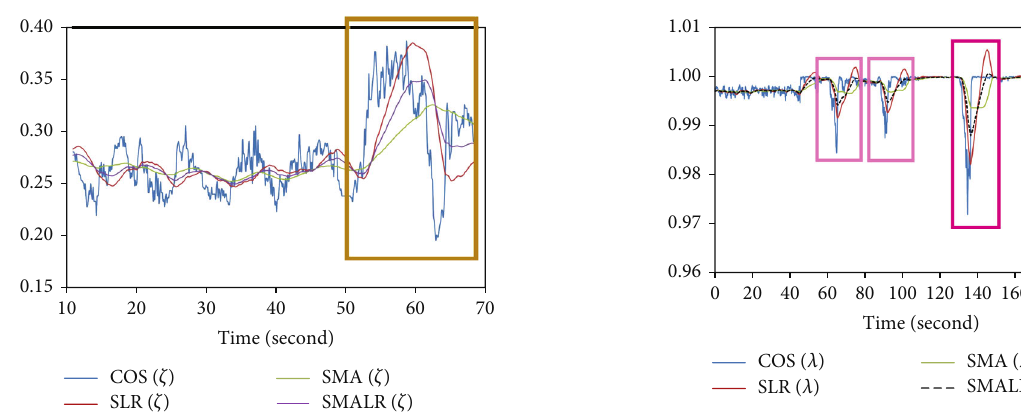
Figure 9: Raw cosine pitch angle versus fi ltering algorithms.